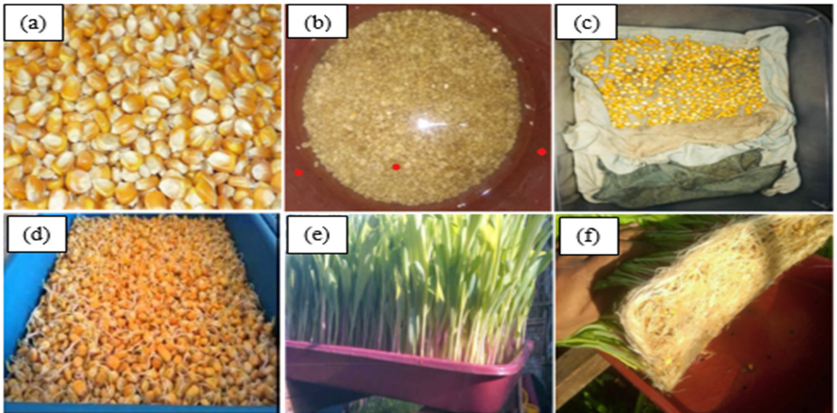
Figure 1. Depiction of growth of Zm root fibres: ( a ) corn seeds; ( b ) seeds soaked in water; ( c ) seeds drained and kept in a wet towel; ( d ) seeds start to germinate; ( e ) growth of corn grass; ( f ) roots of the grown grass.